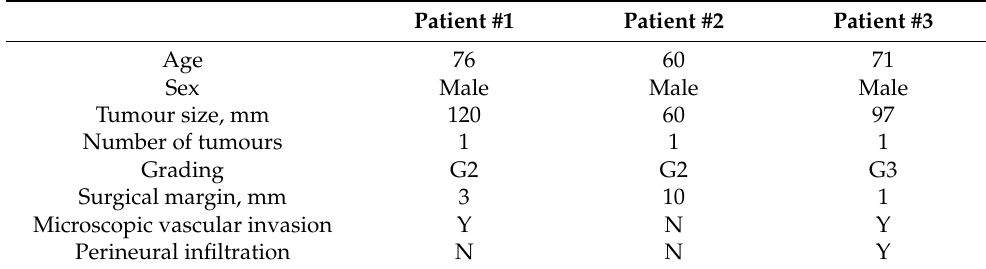
Table 1. Clinical characteristics of the